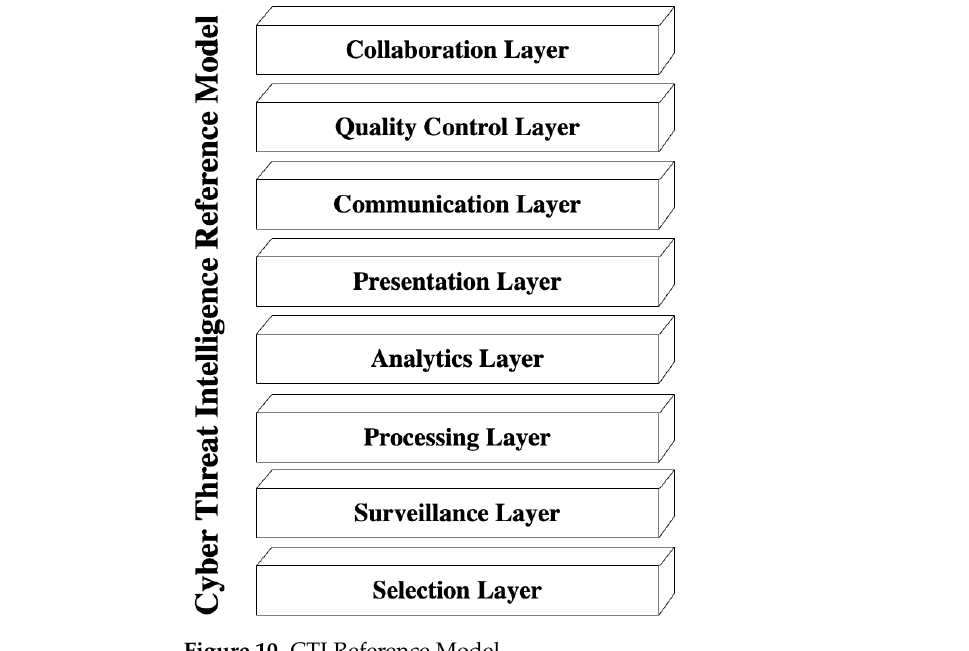
Figure 10. CTI Reference